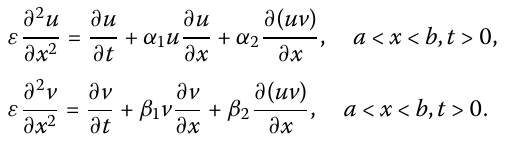
in terms of diffusivity versus time. As the time increases, solution curves decreases to